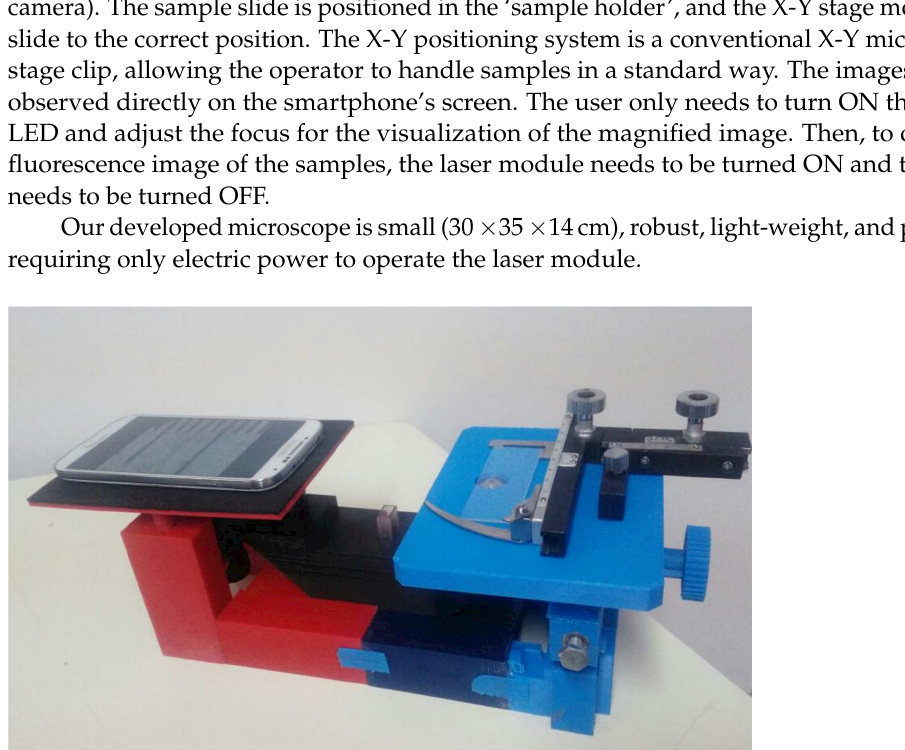
Figure 7. The 3D-printed structure of our smartphone-based inverted laser fluorescence